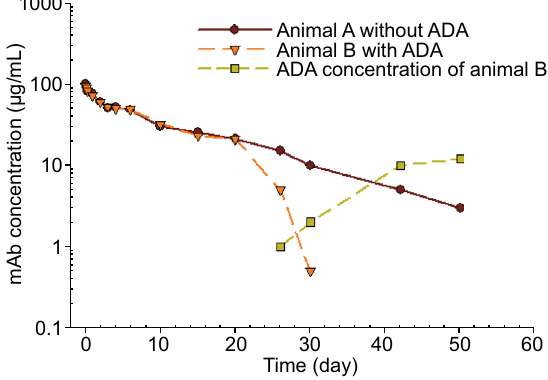
Figure 5. Hypothetical concentration time curves fol- lowing iv administration of a mAb in animals with or without